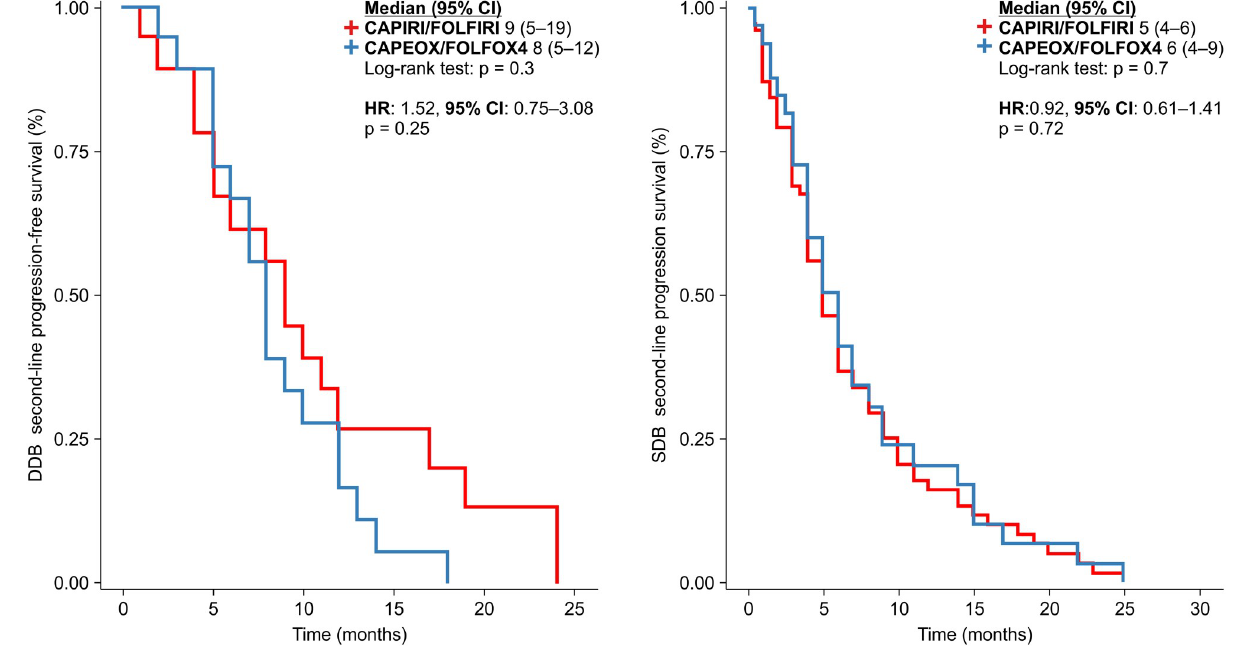
Fig 6. Progression-free survival in the second-line treatment of patients in the double-dose and standard-dose bevacizumab groups.